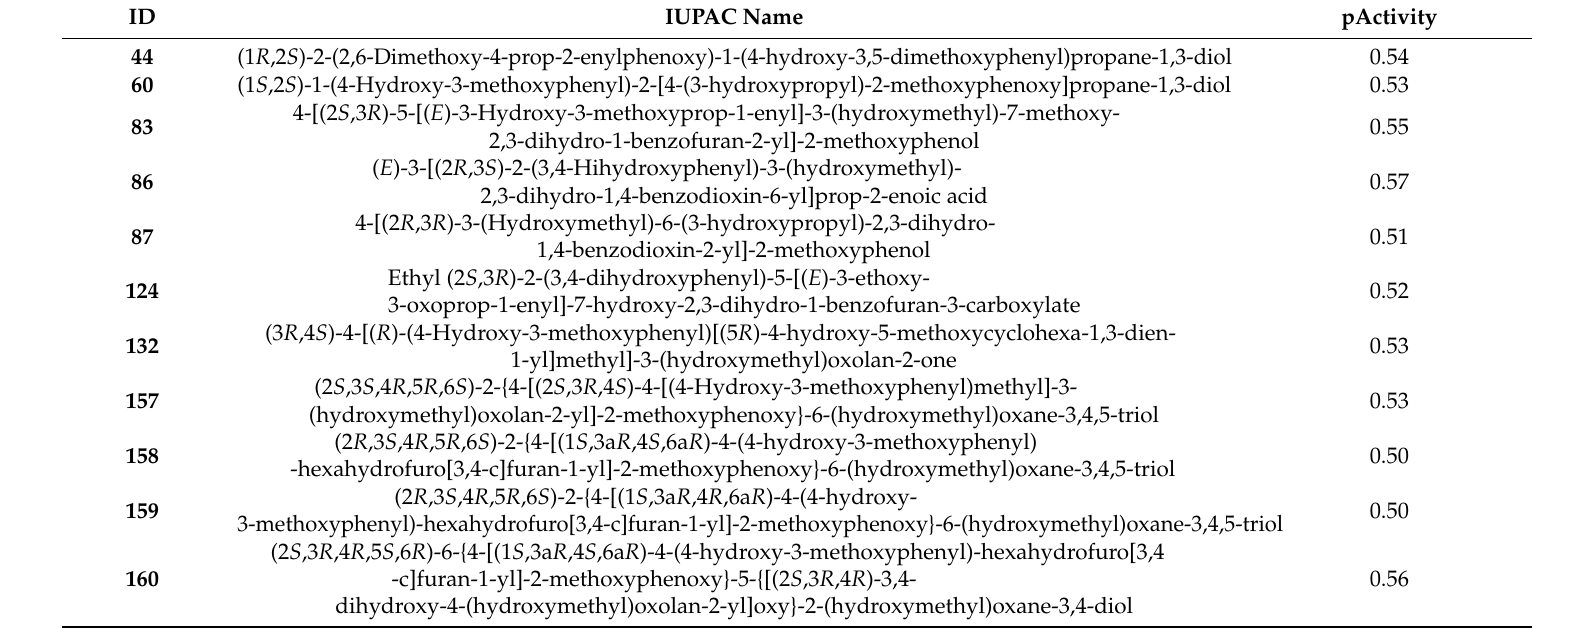
Table 2. Lignans activity probabilities (pActivity) against L. major , as assessed by the RF